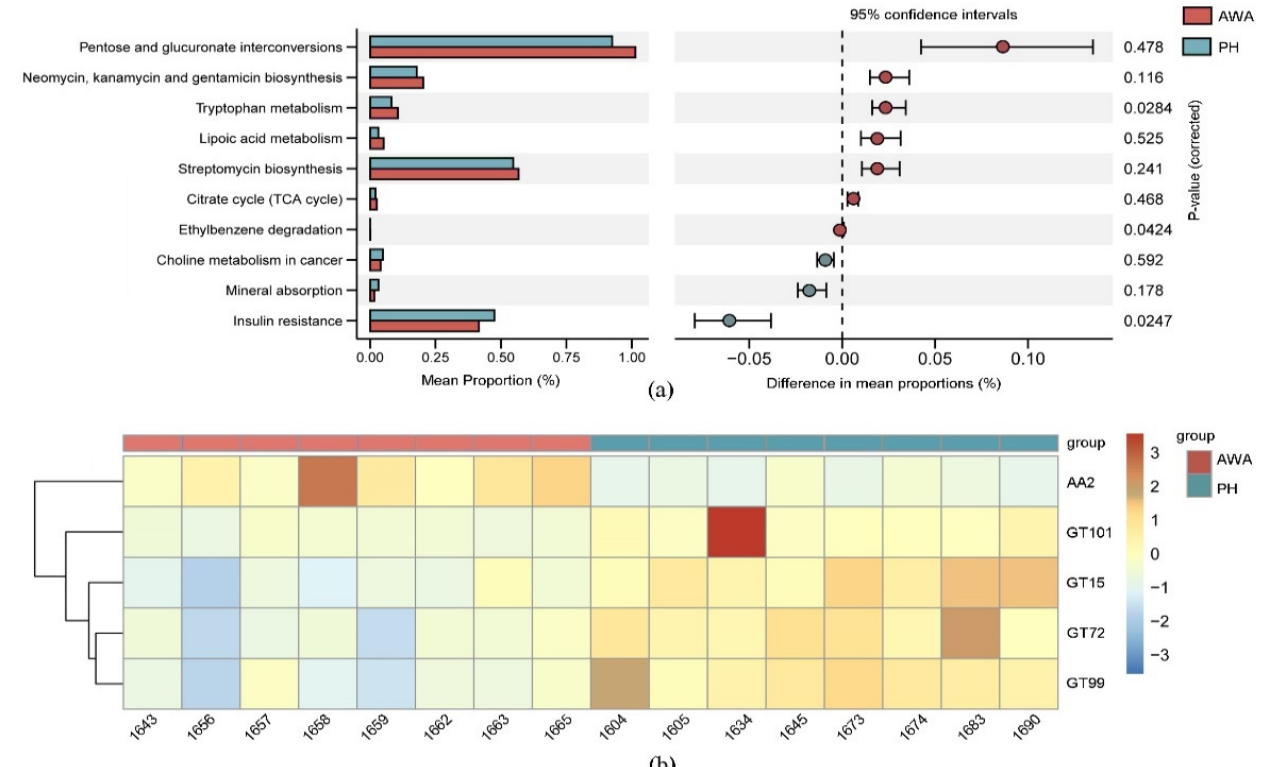
Figure 6. ( a ) The relative abundance of genes related to KEGG pathways (level 3) that were signifi- cantly different between Przewalski’s horses (PH) and Asiatic wild asses (AWA); ( b ) CAZymes that were significantly different between PH and AWA. The differences between groups were identified using STAMP and